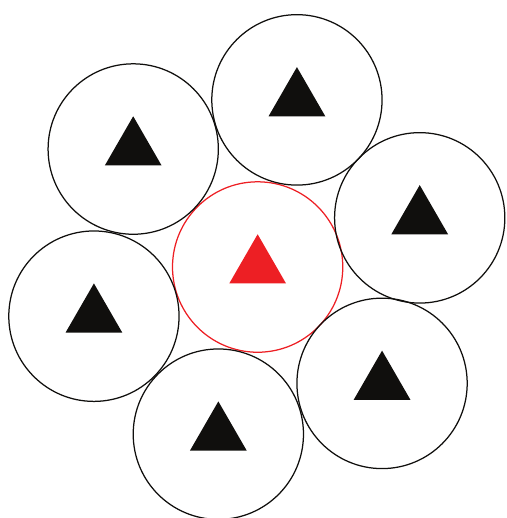
Figure 3: Agent in the center of the cluster exchange information with most 6